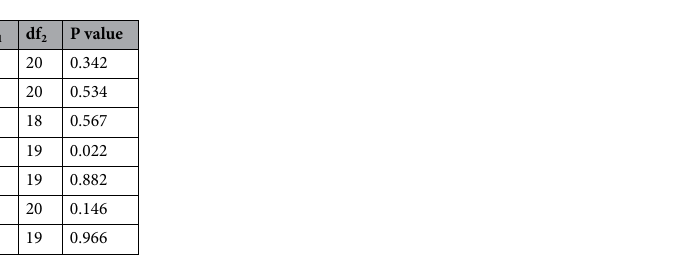
Table 2. Summary statistics for dose–response queen exposures*. *Bonferroni correction: p < α = 0.007 for